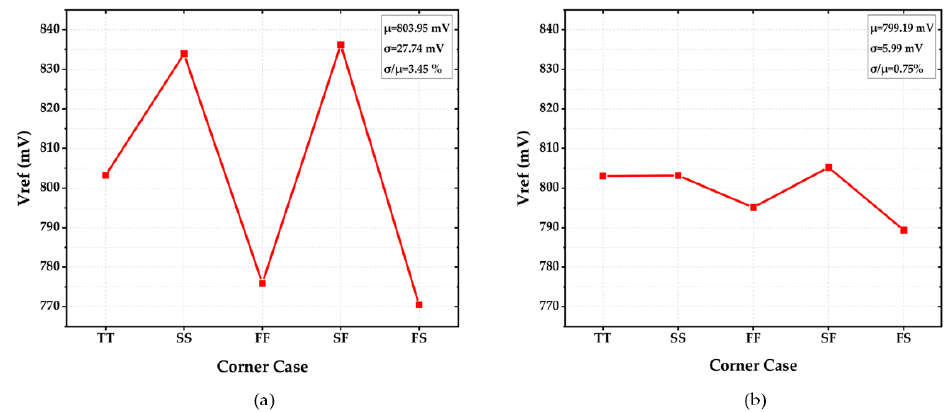
◦ C ( a ) Before Trimming ( b ) After Figure 15. 𝑉 𝑟𝑒𝑓 at Different Corners, 27 ⁡℃ ( a ) Before Trimming ( b ) After Trimming. Figure 15. V ref at Different Corners, 27